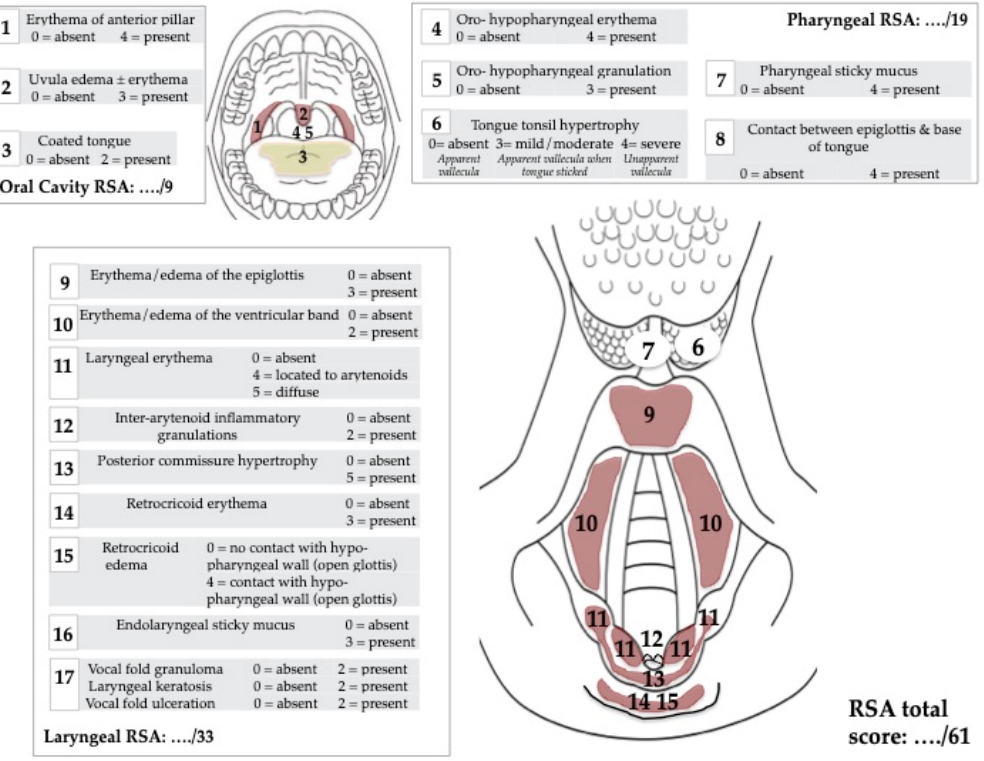
Figure A1. Reflux Sign Assessment.